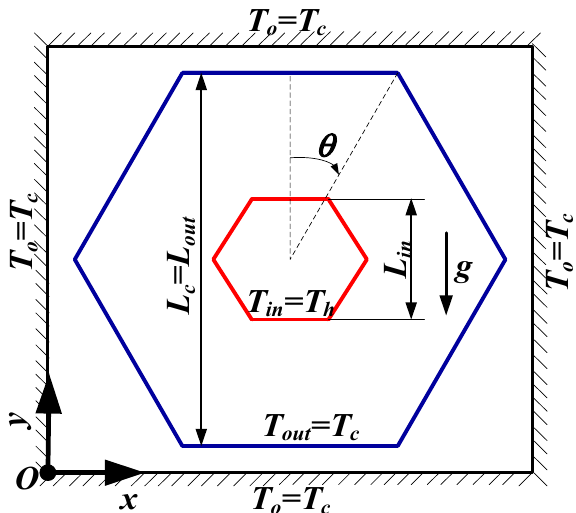
Figure 1. Simulation set-up for investigating the natural convection in an annulus region between two concentric hexagonal cylinders. The origin of the lattice grid is mentioned by ‘ O ’ in the figure. The initial values for the fluid velocity and temperature inside the domain are set to zero. The no-slip and constant temperature BC ( T o = T c ≡ 0) are applied at the enclosure walls for the